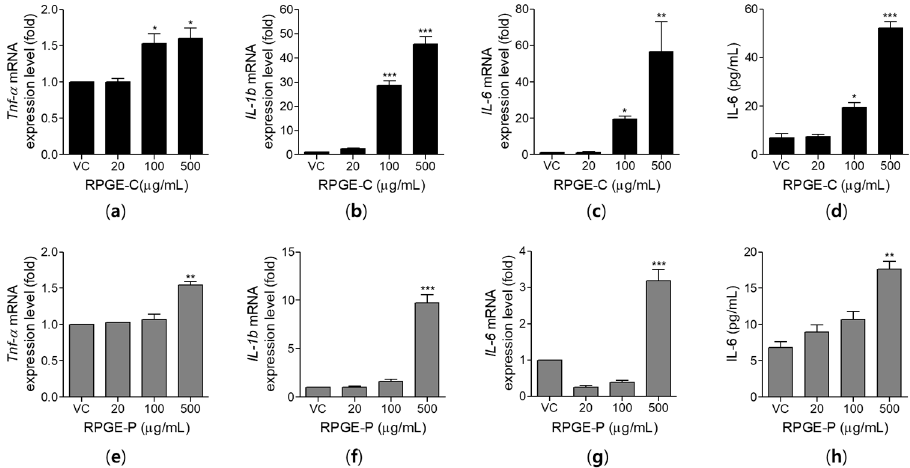
Figure 4. Effect of RPGE on cytokine levels in RAW 264.7 cells. ( a – d ) RPGE-C; ( e – h ) RPGE-P. ( a , e ) Tnf- α mRNA expression level; ( b , f ) IL-1b mRNA expression level; ( c , g ) IL-6 mRNA expression level. The gene expression values were normalized to Actb , and the results were expressed as relative values to that of the VC, which is set to 1. ( d , h ) IL-6 protein levels in the culture supernatant. All data are represented as the mean ± SEM. *p < 0.05, **p < 0.01, and ***p < 0.001 when compared with the VC.